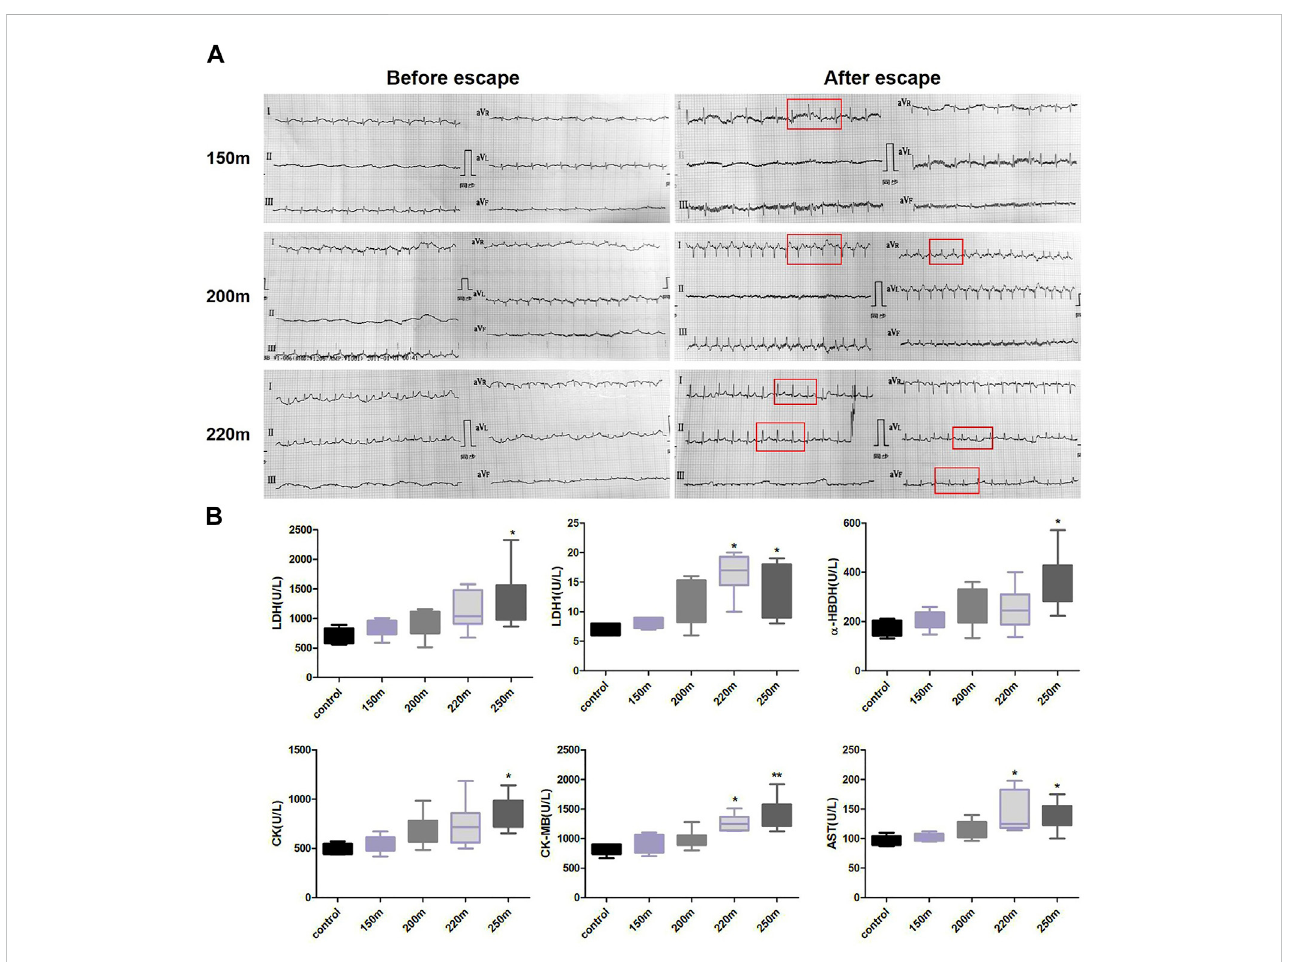
FIGURE 2 Effects of depth of simulated submarine tower escape on ECG activity (A) and myocardial enzyme spectrum (B) . Compared to before escape, increased heart rhythm and sinus arrhythmia were detected in the 150-m escape group. Rapid heart rate, peaked T waves, and Q wave appeared at a depth of 200 m. Pathological Q waves appeared at I, II, aVL, and aVF leads at a depth of 220 m. One-way ANOVA was performed based on the normality of the distribution by Kolmogorov – Smirnov test. Results are the minimum to maximum values ( n = 5 – 7 per group). * p < 0.05, ** p < 0.01 compared to the